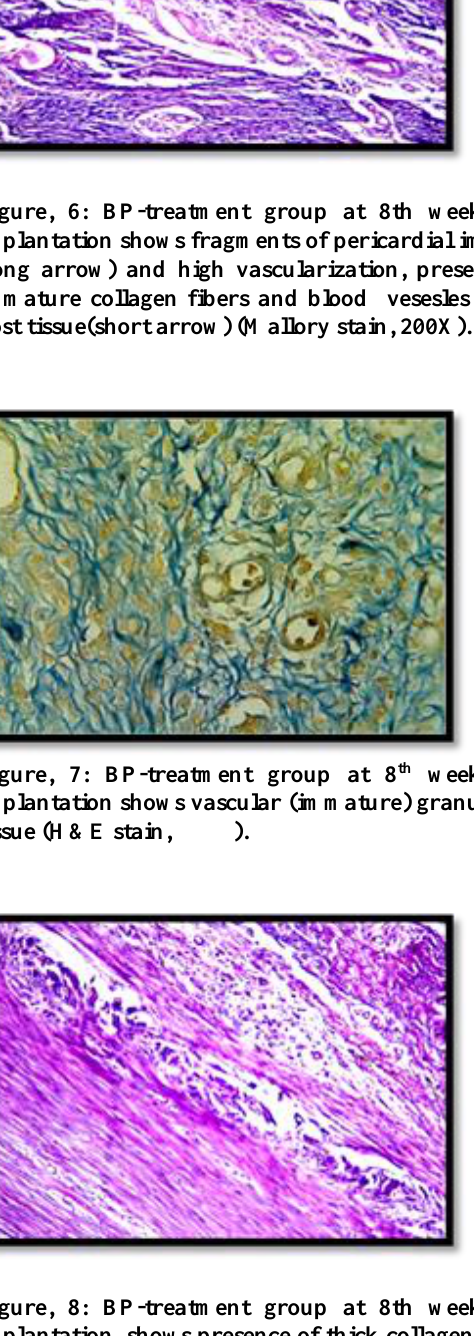
Figure, 5: BP-treatment group at 2 nd week post implantation, shows fragment of muscles fibers observed within the necrotic area (long arrow) with calcium precipitation (short arrew) (Mallory stain,